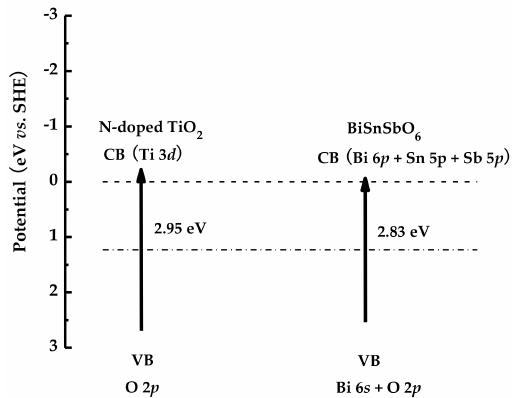
Figure 14. Proposed band structures of BiSnSbO 6 and N-doped TiO 2 .